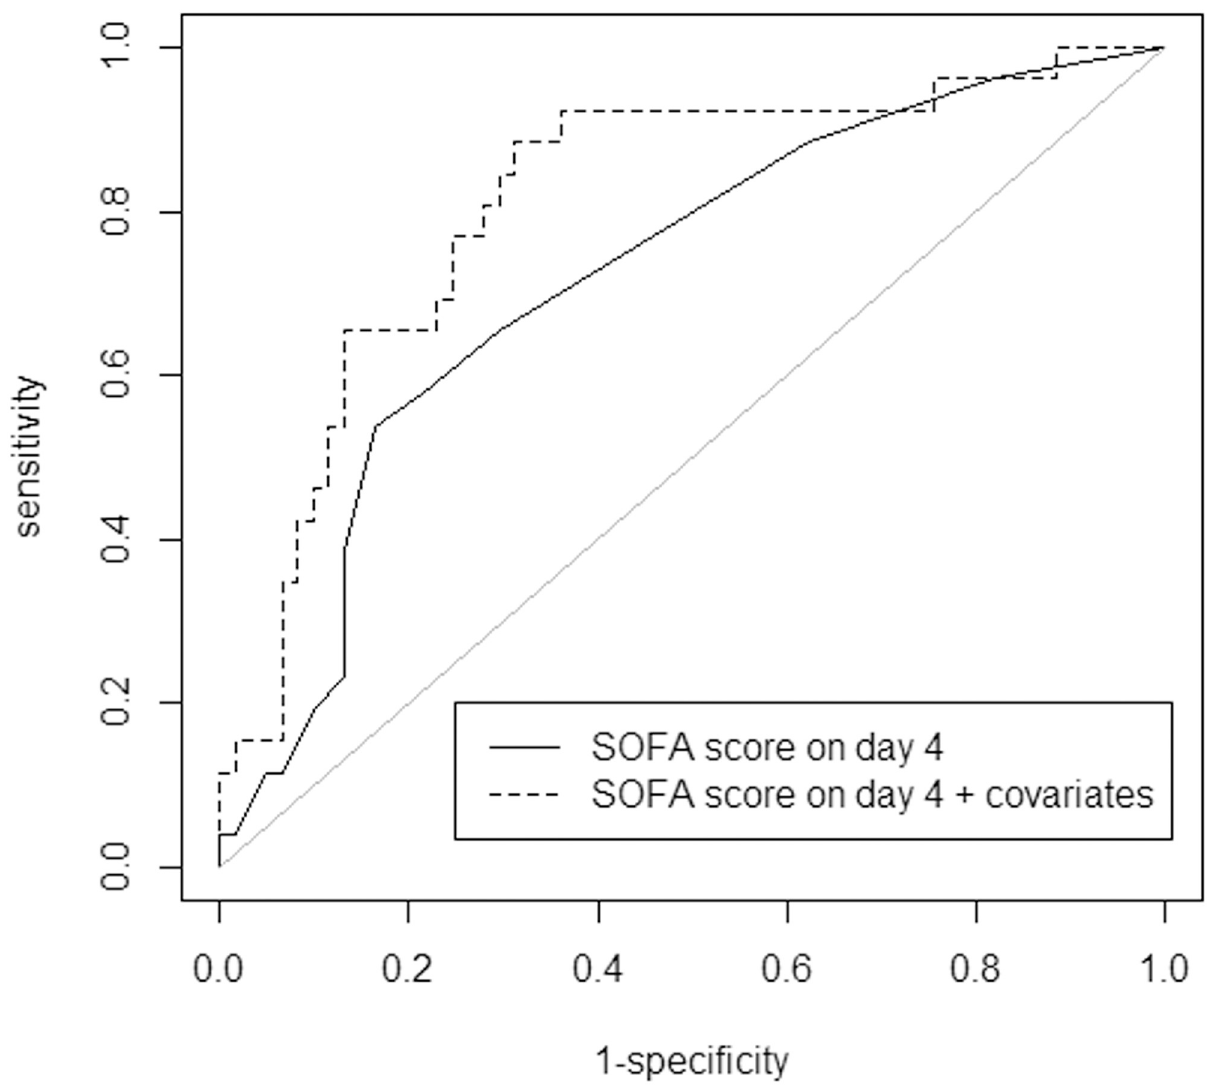
Fig 2. Receiver operating characteristic (ROC) curves of predictive models for 3-month mortality in 87 critically ill octogenarians. The continuous line represents the ROC curve of the sequential organ failure assessment (SOFA) score on day 4 after admission to the intensive care unit as a predictor of 3-month mortality. The dashed line represents the ROC curve of the multivariate Cox model including the SOFA score on day 4, neurological failure on admission and the number of preadmission medications as a predictor of 3-month mortality. The area under the ROC curve (AUC-ROC) of the SOFA score on day 4 was 0.72 (95% CI, 0.60 to 0.84), and the AUC-ROC curve of the SOFA score on day 4 with covariates added was 0.81 (95% CI, 0.71 to